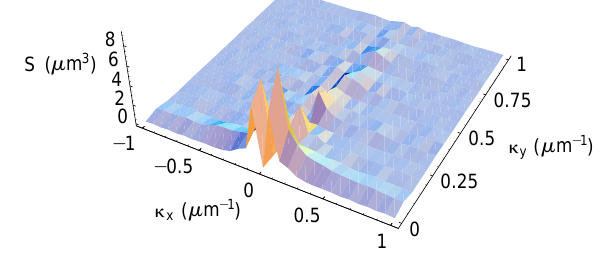
FIG. 3. (Color) Spectrum S (cid:1) j ˆ h 0 (cid:1) k x , k y (cid:2) j for the 100 m m 3 100 m m sample.